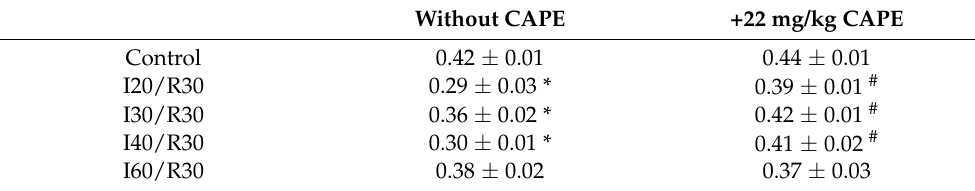
Table 2. Effect of ischemia/reperfusion and CAPE on LDH activity in the cytosolic fraction. Without CAPE +22 mg/kg CAPE Control 0.42 ± 0.01 0.44 ± 0.01 I20/R30 0.29 ± 0.03 * 0.39 ± 0.01 # I30/R30 0.36 ± 0.02 * 0.42 ± 0.01 # I40/R30 0.30 ± 0.01 * 0.41 ± 0.02 # I60/R30 0.38 ± 0.02 0.37 ±